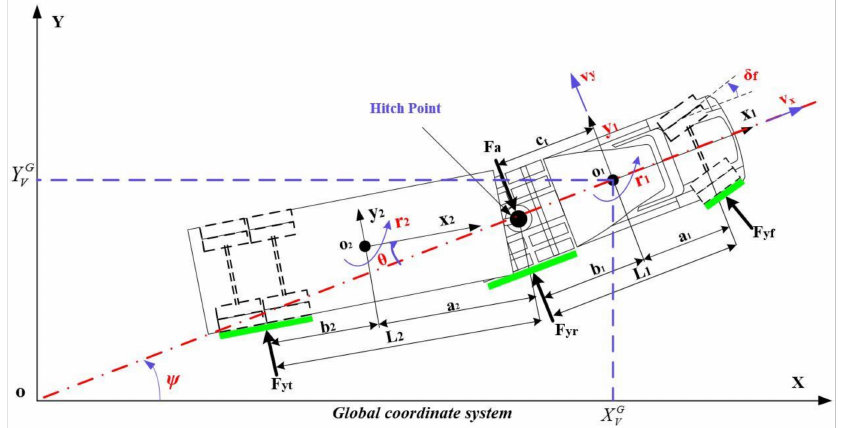
Figure 1. Three DOF linear yaw-model of tractor-semitrailer.